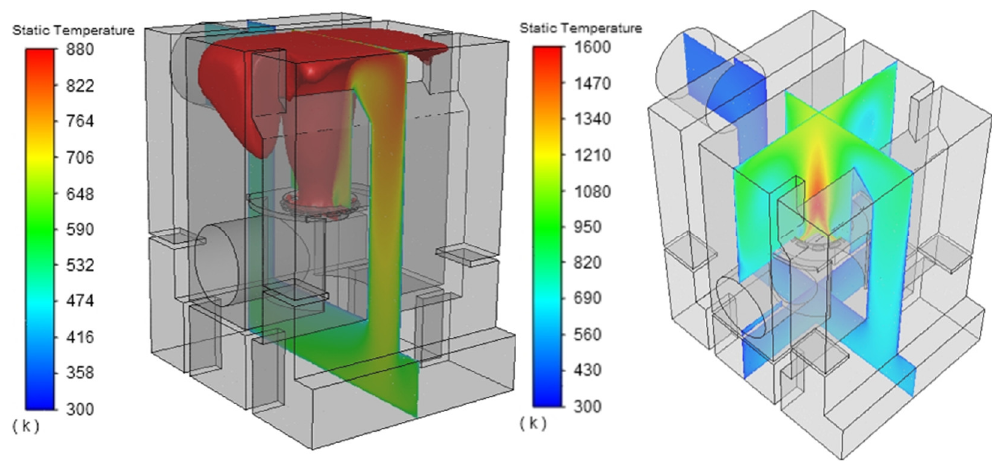
Figure 9. Temperature distribution (K) with determined temperature zone of above 880 K.